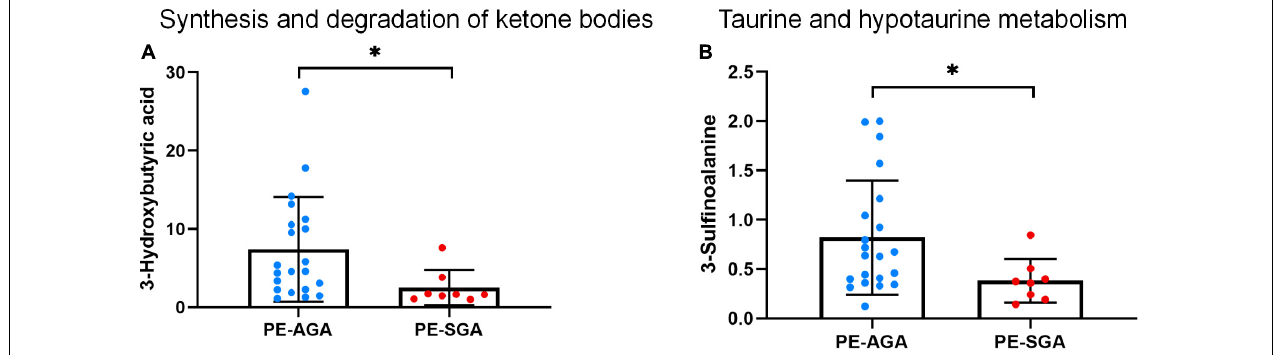
FIGURE 9 | The decreased abundance of differential metabolites in two important metabolic pathways related to PE-SGA neonates. (A) Synthesis and degradation of ketone bodies. (B) Taurine and hypotaurine metabolism. Mean, standard deviation, and p -values are shown in the graph. ∗ represents p <